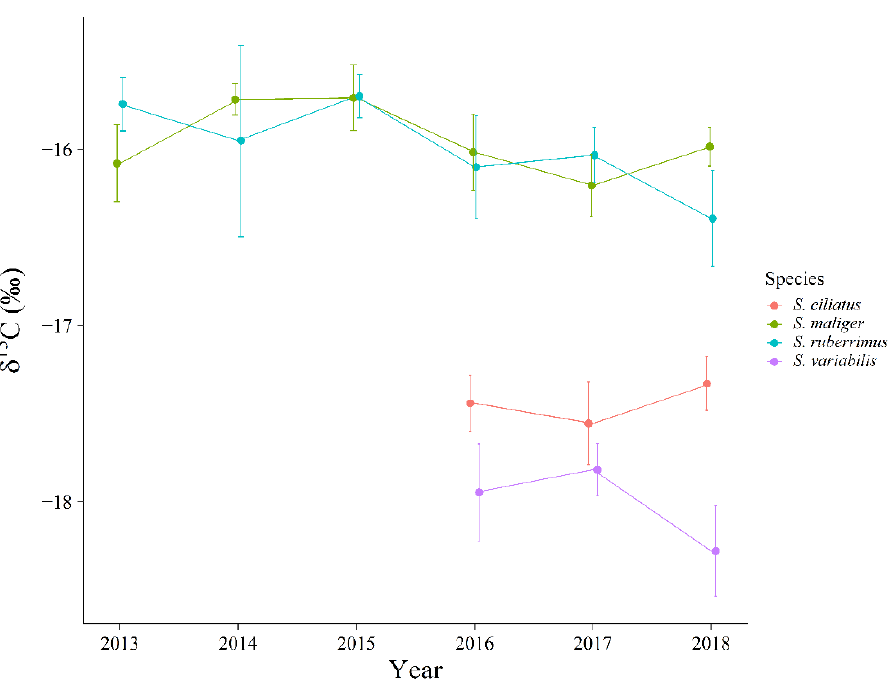
Figure 6. Mean shifts in δ 13 C and 95% confidence intervals across time for four rockfish species in this assemblage.